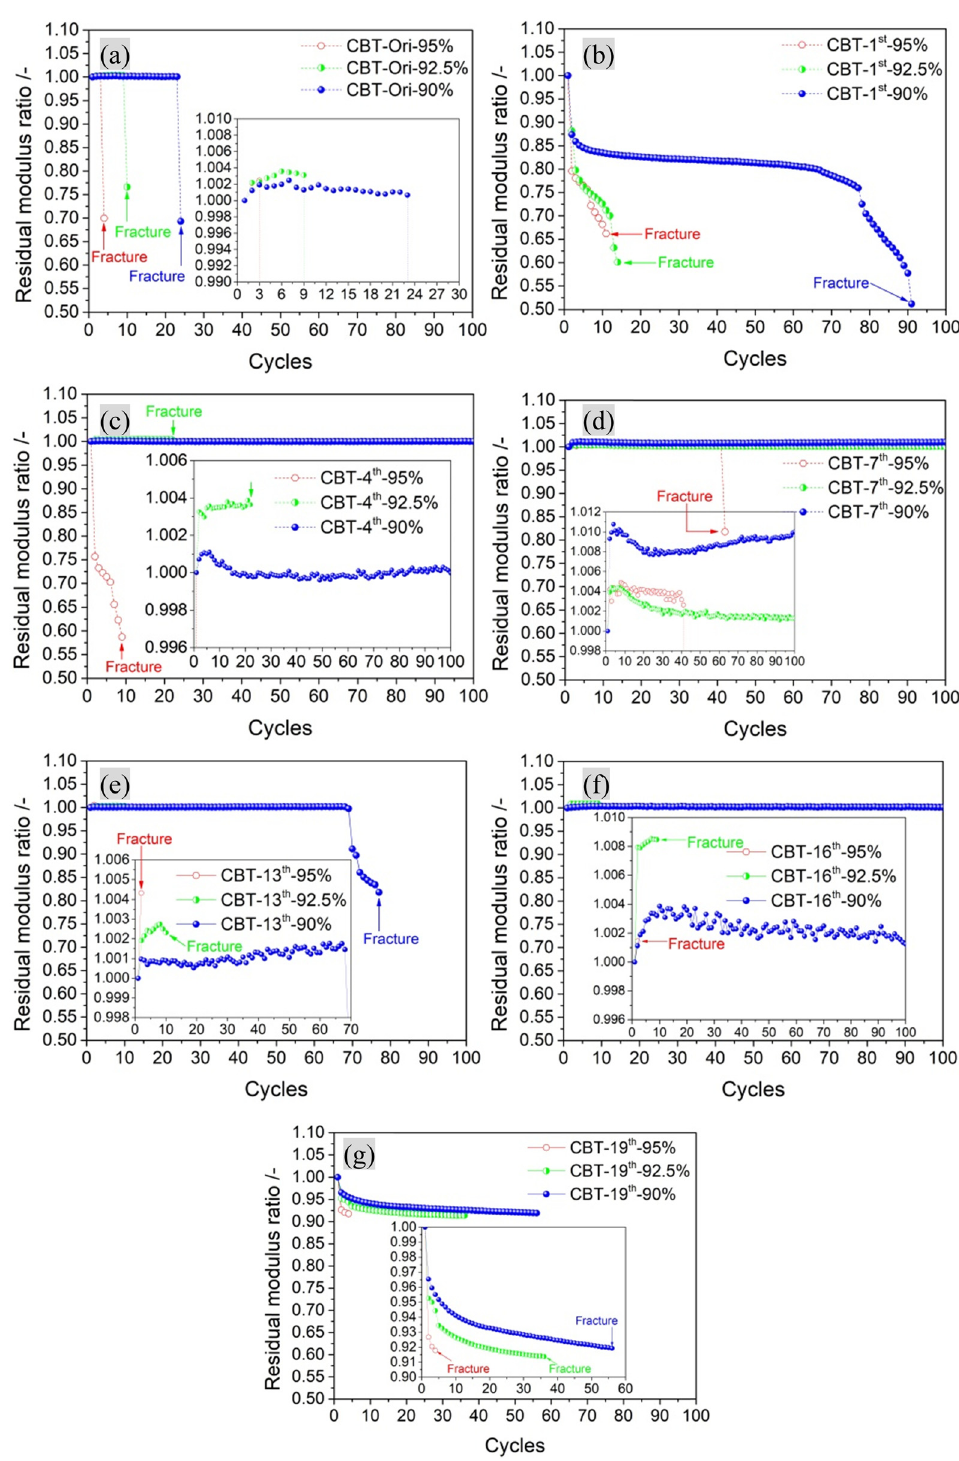
Figure 9: Relationship between residual modulus ratio and cycles to failure of CF/epoxy laminates with and without fiber breakage in different layers: ( a ) original, ( b ) 1st layer, ( c ) 4th layer, ( d ) 7th layer, ( e ) 13th layer, ( f ) 16th layer, and ( g ) 19th